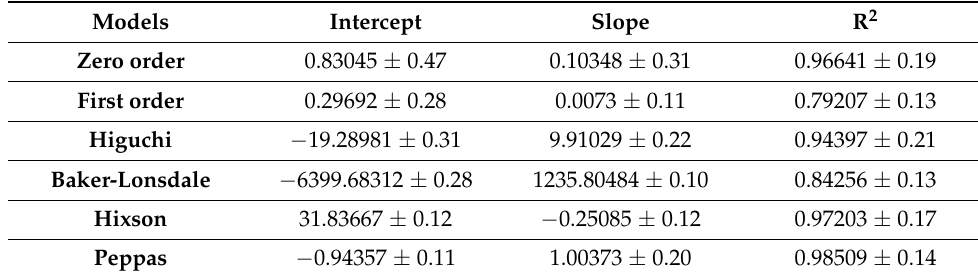
Figure 6. Drug release kinetics of prepared hydrogel with different mathematical models (Zero-order, First-order, Hixson, Baker-Lonsdale, Higuchi and Peppas model to analyze drug release behavior. Table 3. Drug release kinetic by different